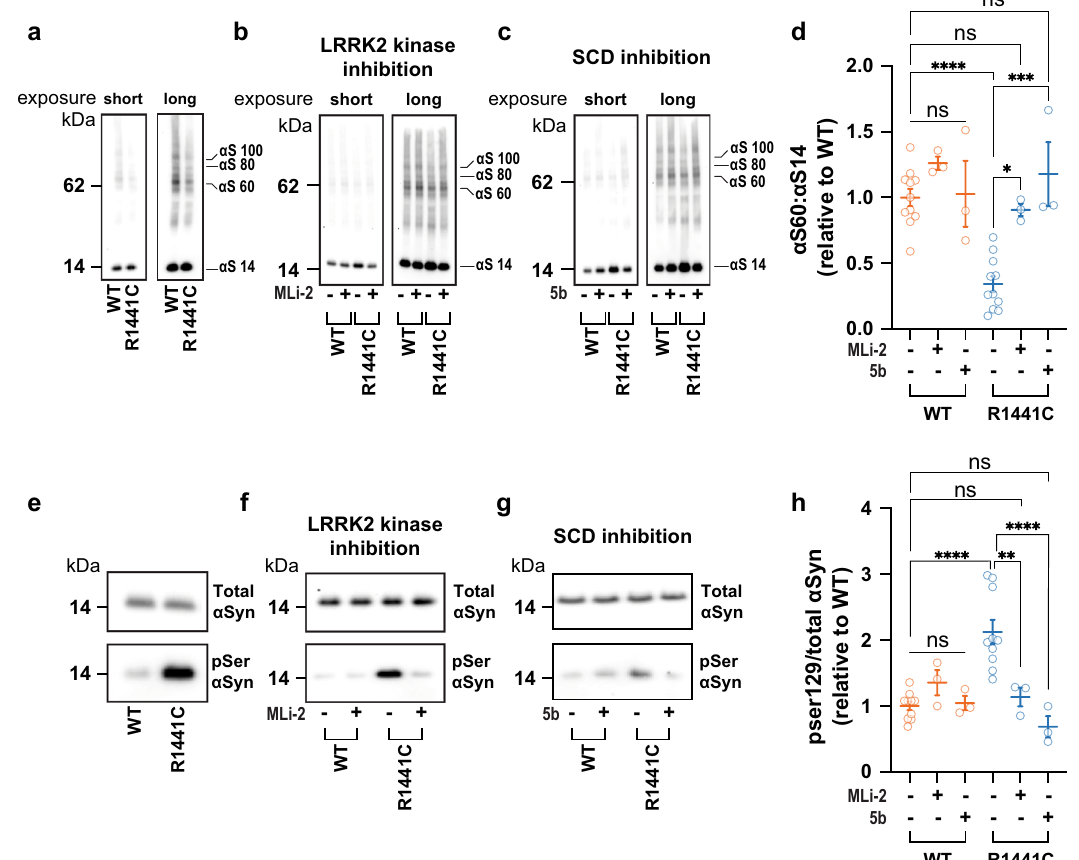
Fig. 5 The R1441C LRRK2 mutation also decreases the physiological α Syn T:M ratio. a Representative WBs of patient lines bearing the LRRK2 R1441C mutation show signi fi cantly decreased α Syn T:M ratios. Treatment with either a LRRK2 kinase inhibitor (MLi2) ( b ) or an SCD inhibitor (5b) ( c ) restored the physiologic T:M ratio WT levels d . e R1441C also increases pSer129 phosphorylation of α Syn. f Inhibiting LRRK2 kinase or g inhibiting SCD reduced pSer129 levels. h Quantifying the ratio of pSer129 to total α Syn (for both d and h , N ≥ 3 independent experiments; each dot is an independent replicate sample; one-way ANOVA with Tukey ’ s post hoc test; error bars = SEM; * p < 0.05, ** p < 0.01, *** p < 0.001, **** p <